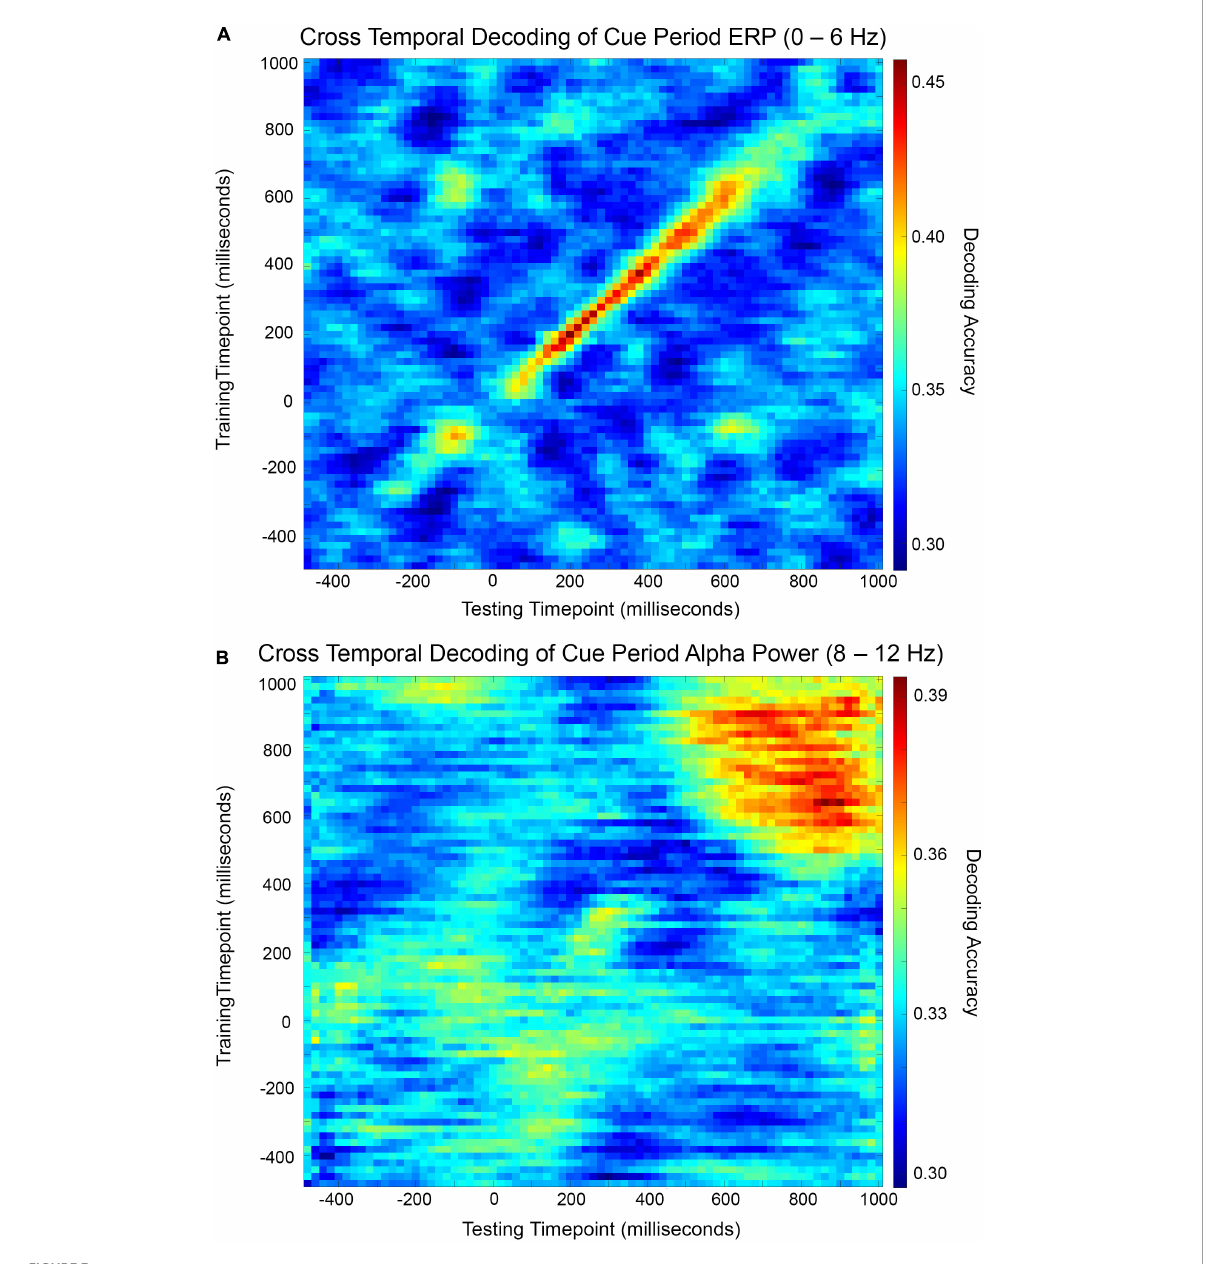
FIGURE3 Cross-temporal cue period decoding accuracy matrices for ERP (A) and alpha power (B) . Decoding accuracy was measured for each combination of training time point and testing time point and visualized by color